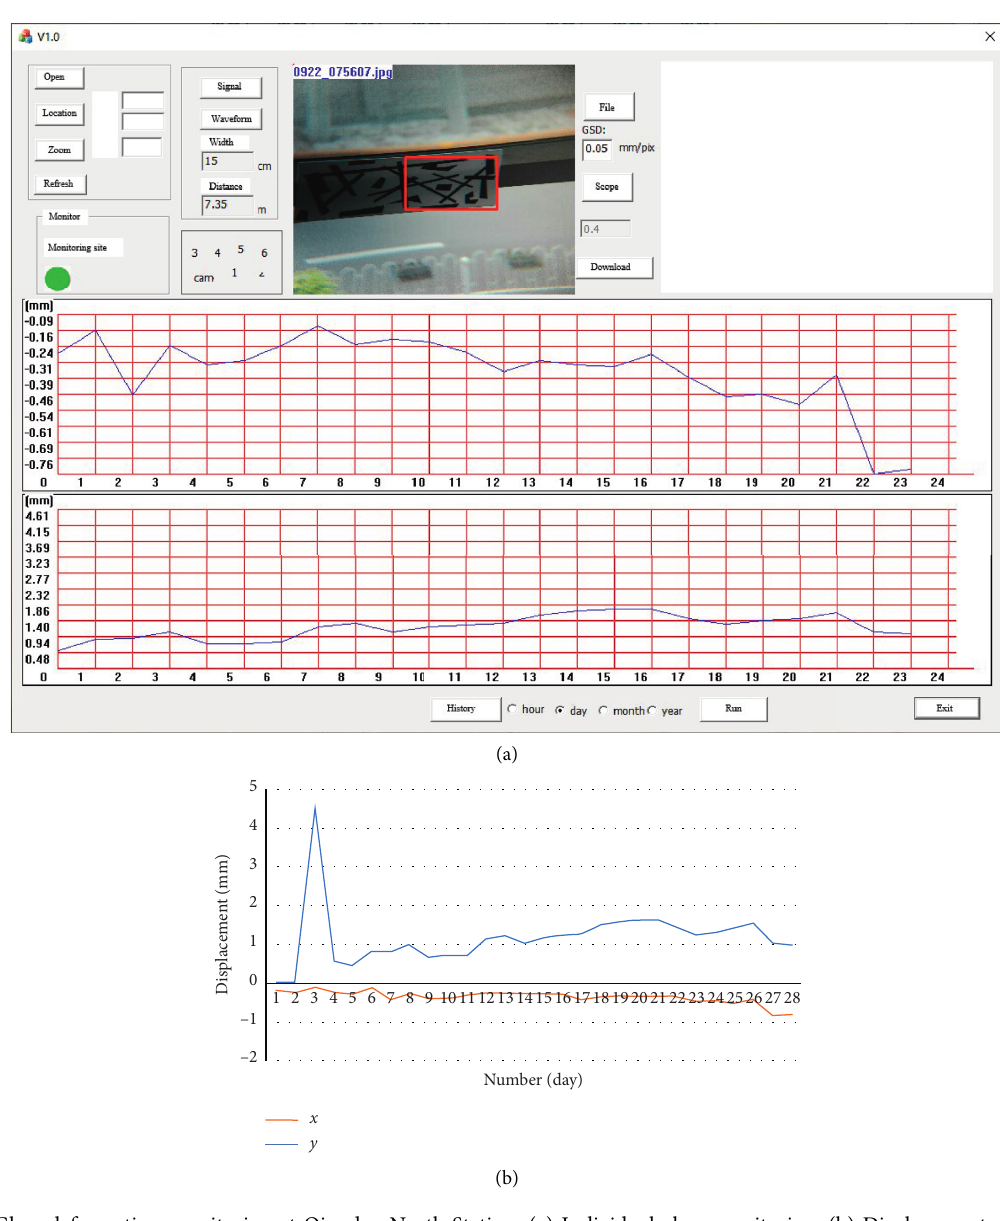
Figure 13: Glass deformation monitoring at Qingdao North Station. (a) Individual glass monitoring. (b) Displacement change